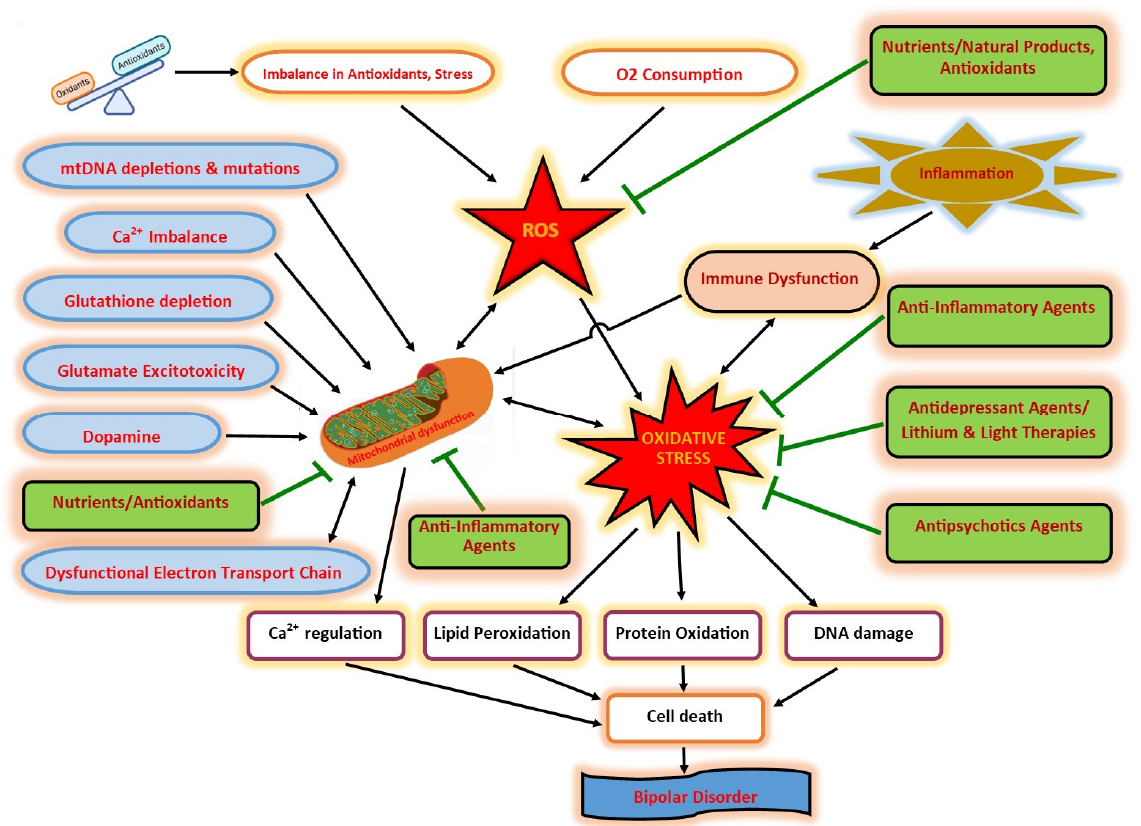
Figure 1. The potential interactions between BD, OS, mitochondrial dysfunction, immune dysfunc- tion, antioxidants, antidepressant agents, anti-inflammatory agents, antipsychotic agents, and light therapies.